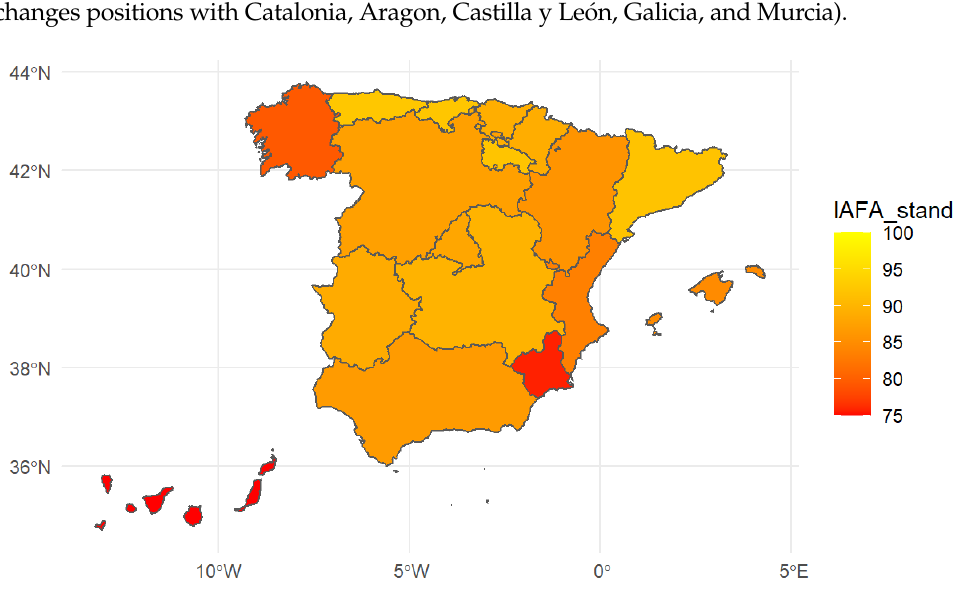
Figure 5. Standardized regional Index of Autonomy in Food Acquisition in Spain, 2020. Source: compiled by the authors based on data from EHSS, 2020 ( n = 6676).